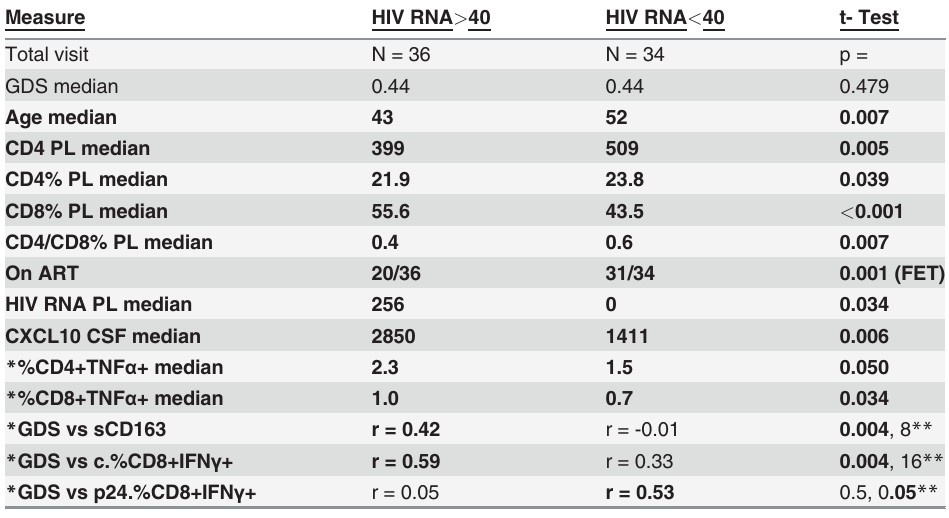
Table 4. Division of data according to CSF HIV RNA detectability reveals distinct CD8 T-cell and monocyte in fl ammatory responses correlations with NC impairment in the HIV RNA detectable and HIV RNA undetectable